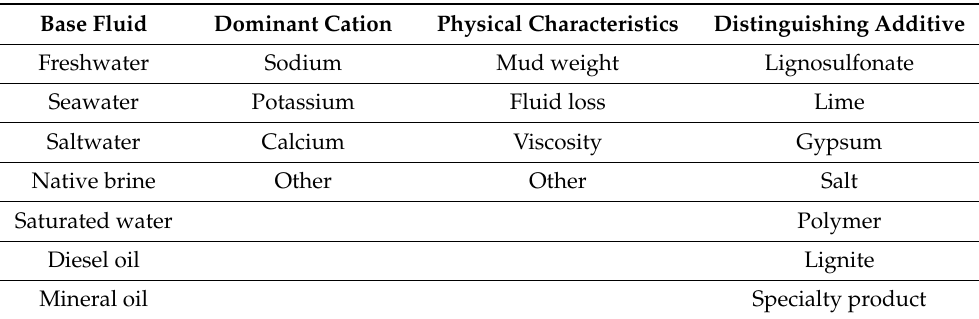
Table 2. Physical properties of different drilling fluids containing varying chemical additives [102]. Base Fluid Dominant Cation Physical Characteristics Distinguishing Additive Freshwater Sodium Mud weight Lignosulfonate Seawater Potassium Fluid loss Lime Saltwater Calcium Viscosity Gypsum Native brine Other Other Salt Saturated water Polymer Diesel oil Lignite Mineral oil Specialty